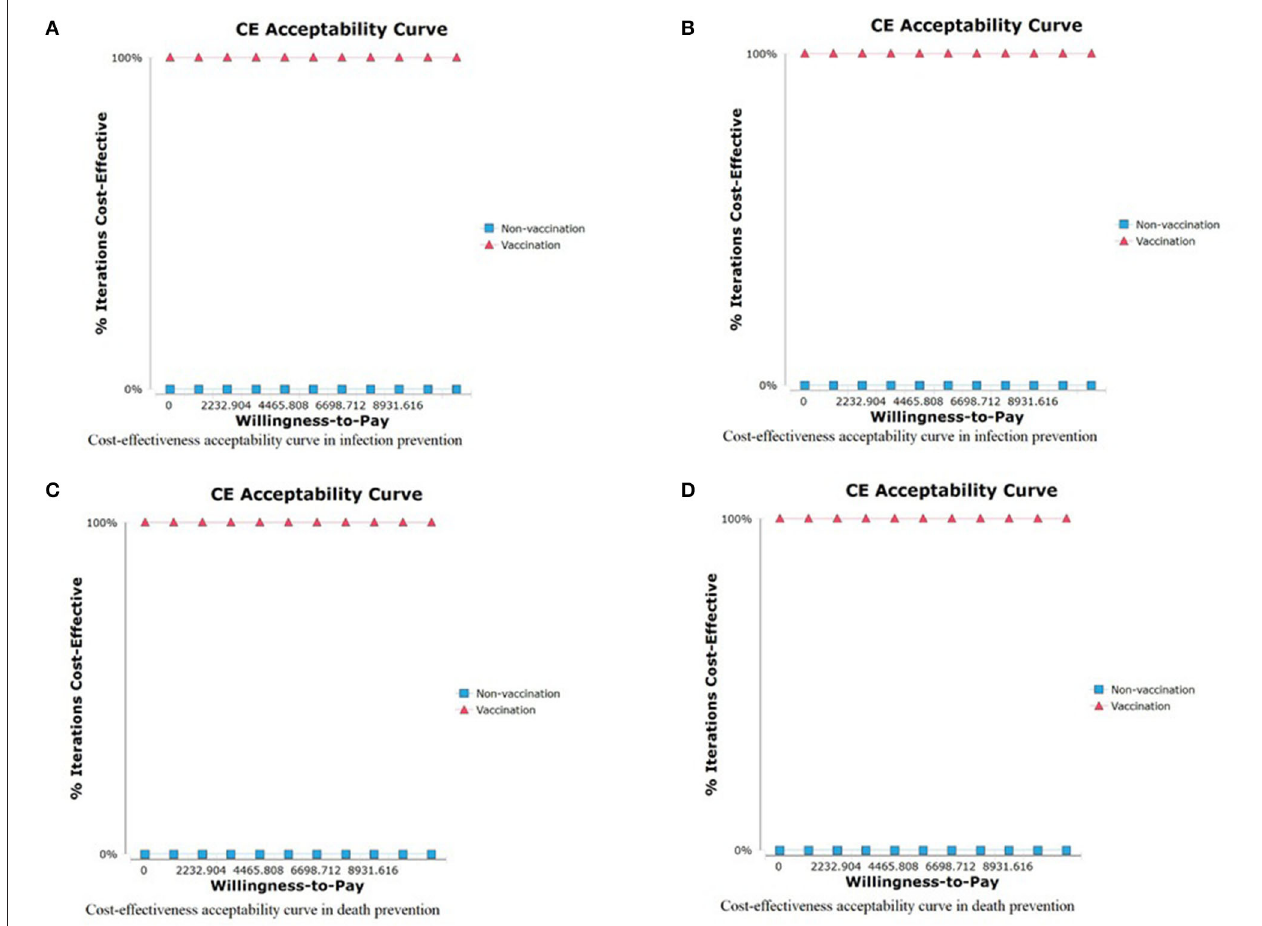
FIGURE 5 | Cost-effectiveness acceptability curve. (A) CEA curve of COVID-19 infection prevention, (B) CEA curve of COVID-19 hospitalization prevention, (C) CEA curve of COVID-19 ICU admission prevention, and (D) CEA curve of COVID-19 related death